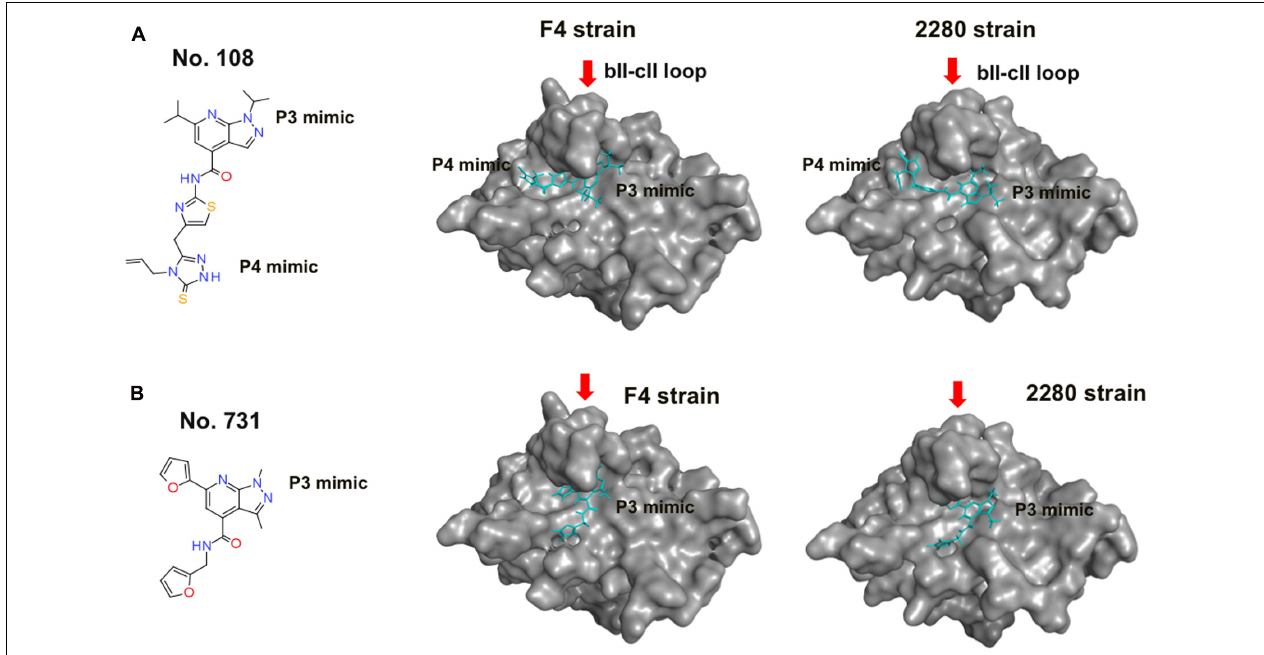
FIGURE 5 | Binding modes of No. 108 and No. 731 to FCV proteases. (A) No. 108. (B) No. 731. Left panels: molecular formulas of the compound. Middle and Right panels: structural models of the FCV proteases docked to each compound. Each compound was docked with the protease domain of the FCV F4 strain (Oka et al., 2007) (GenBank accession number: D31836) or the 2280 strain (Oka et al., 2013) (Genbank accession no. KC835209) using the automated ligand docking program ASEDock 2005 (Goto et al., 2008) operated in MOE as described previously (Yokoyama et al., 2012b). The structures with the best docking score expressed by the arbitrary docking energy (U dock ) in ASEDock2005 are shown. Red arrows indicate the bII-cII loop (Fernandes et al., 2015) near the substrate binding site. No. 108 is shown using a cyan stick